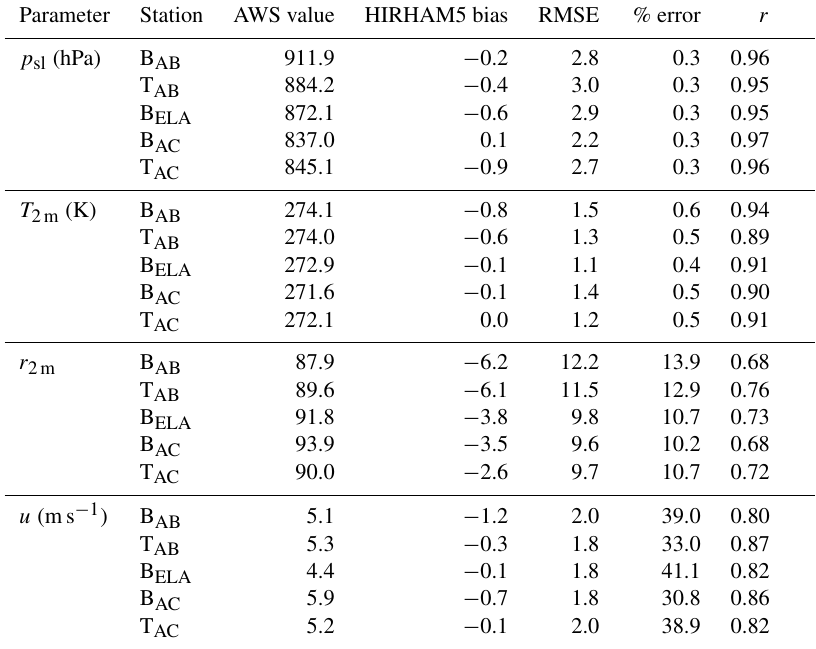
Table 2. Comparison of the surface pressure p sl , air temperature at 2m, T 2m , relative humidity r 2m , and wind speed u , from HIRHAM5 sim- ulations and AWS measurements during the summer months (April–October) for the period 2001–2014. The HIRHAM5 bias (HIRHAM5- AWS), the root-mean-square error (RMSE), the percentage error, and the correlation ( r ) are shown. Parameter